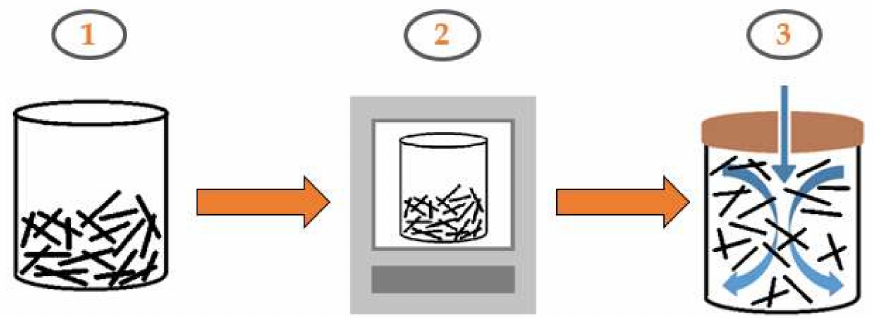
Figure 1. Chopped carbon fiber coupling agent removal process: ( 1 ) chopped carbon fiber; ( 2 ) carbon fiber heated at 550 ◦ C (muffle furnace); ( 3 ) pneumatic dispersion.